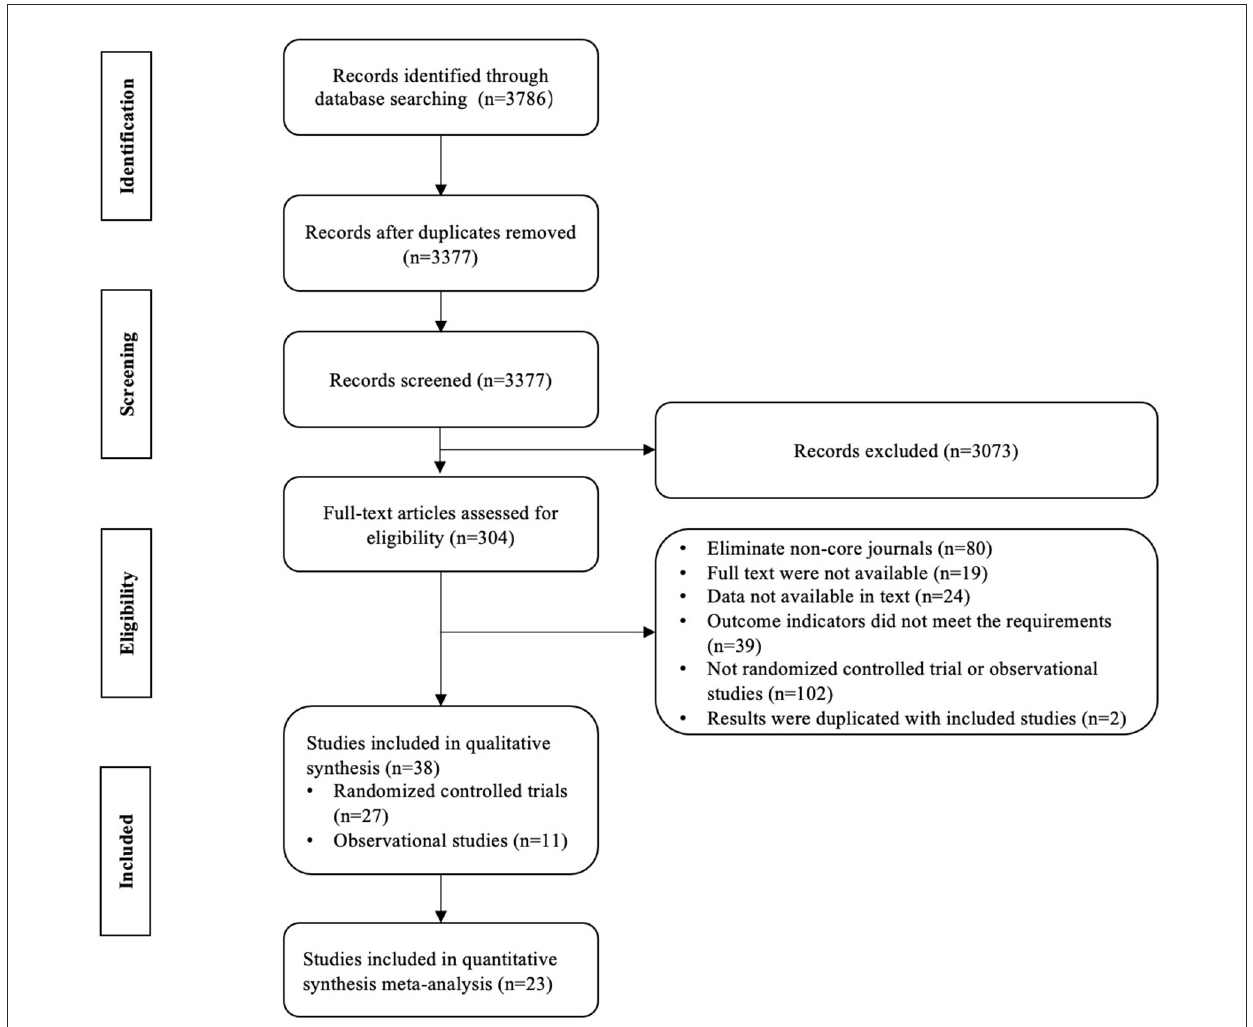
FIGURE1 PRISMA flowchart of literature retrieval and selection.